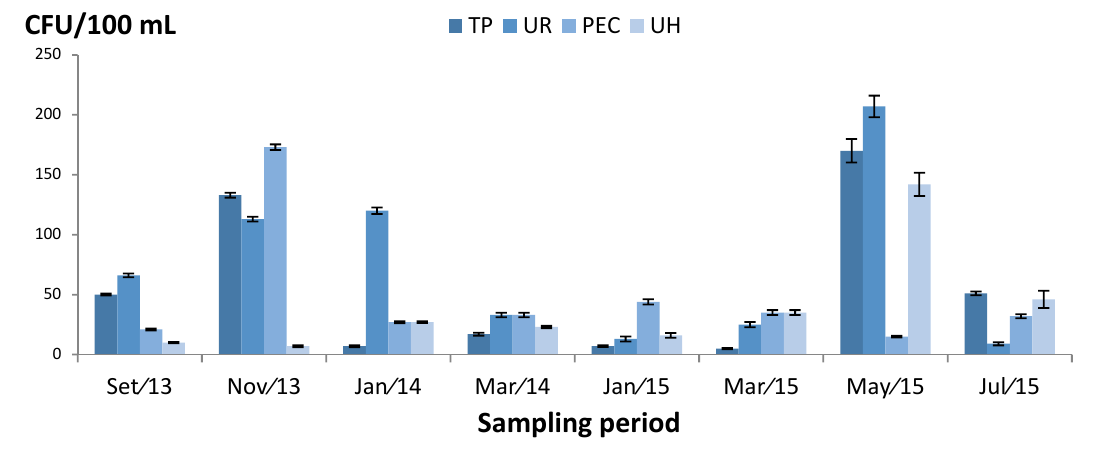
Figure 1. Quantification of water fungi express in colony forming units (CFU)/100 mL in different sampling sites and period. TP: Water treatment plant; UR: Univ. restaurant; PEC: Physical education center; UH: Univ. hospital.